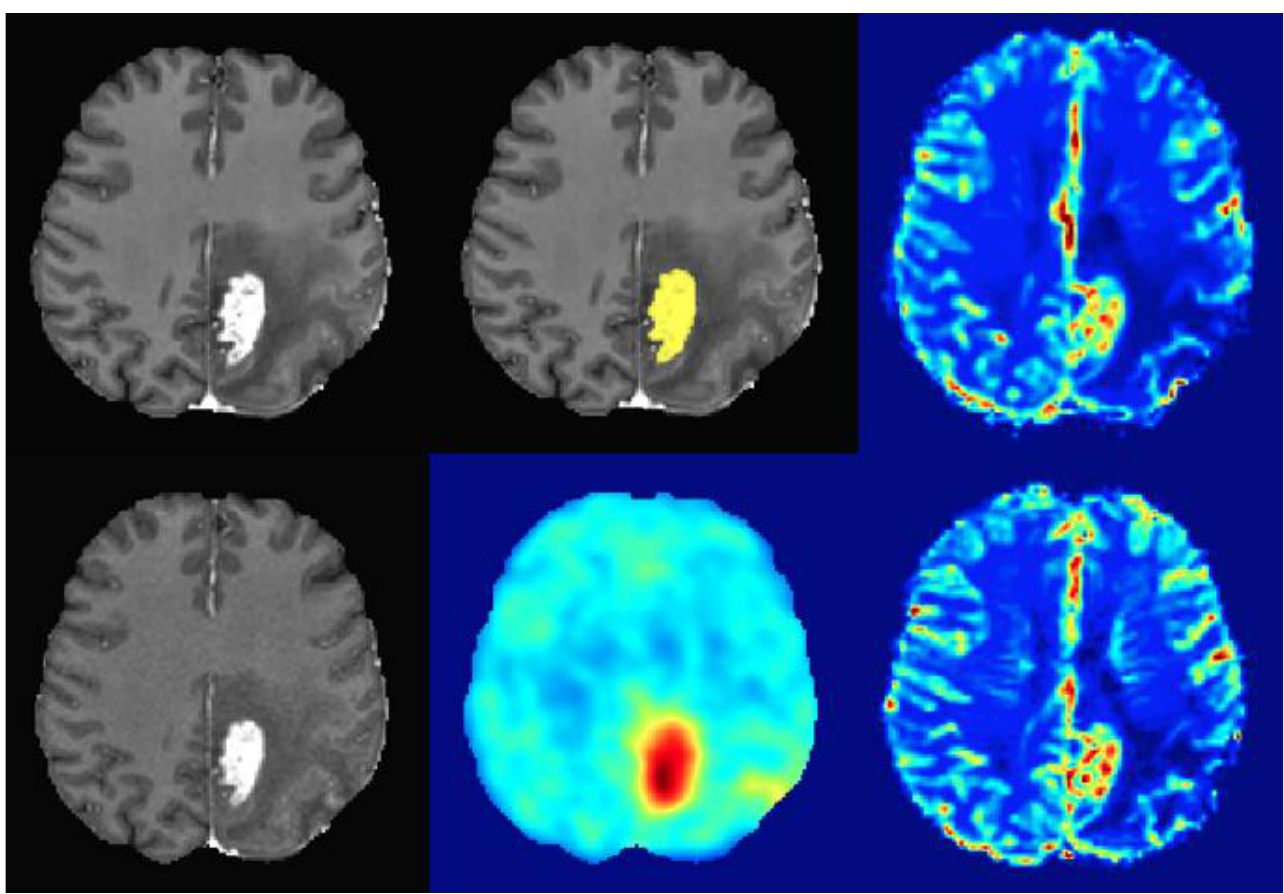
Figure 1. Exemplary images of a 57-year-old female patient with left parietal glioblastoma (upper left: MRI contrast-enhanced T1, upper middle: MRI contrast-enhanced T1 with automated segmentation overlay (yellow: CET), upper right: MRI CBV, lower left: PET/MRI contrast-enhanced T1, lower middle: FET-PET, lower right: PET/MRI CBV).